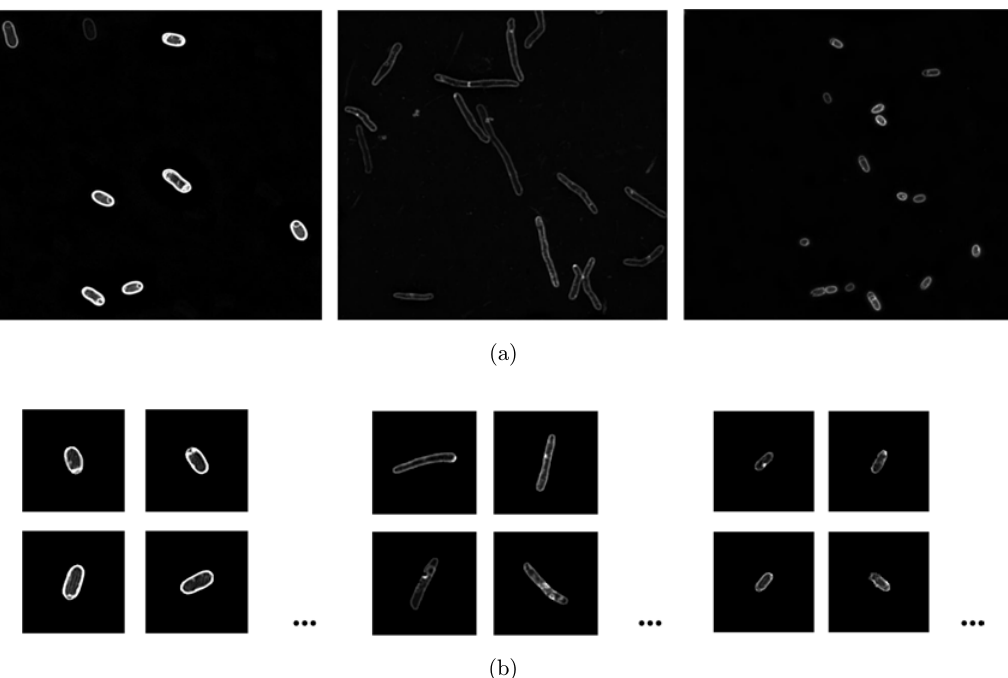
Fig. 2. Representative SIM images of the bacteria. (a) Raw SIM images of E. coli (left), Mycobacterium smegmatis (middle) and Pseudomonas aeruginosa (right). (b) Resized positive images for a standard training library.